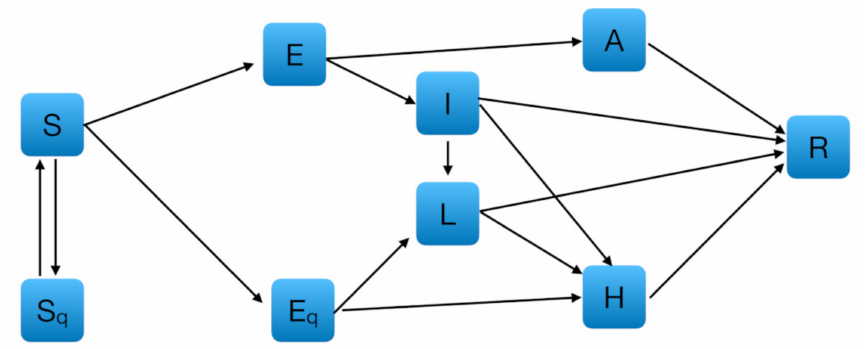
Figure 1. Diagram of the extended Susceptible-Exposed-Infectious-Recovered (SEIR) model adopted for simulating the spread of coronavirus disease 2019 (COVID-19) in Lombardy and Emilia-Romagna. S : susceptible, S q : quarantined susceptible, E : exposed, E q : quarantined exposed, I : infectious with symptoms, L : isolated infectious, A : infectious without symptoms, H : hospitalized, R :